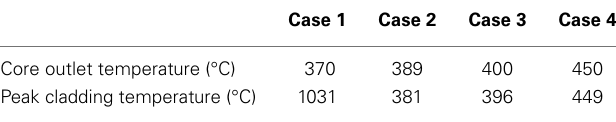
Table 4 | Sensitivity analysis on core outlet temperature